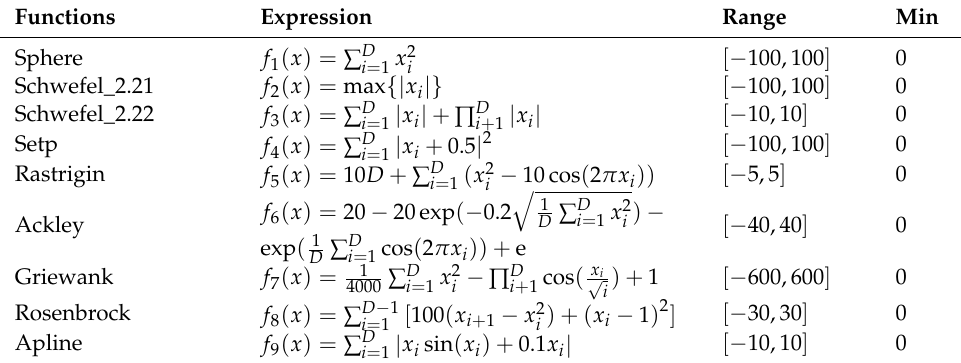
Table 2. Test functions.